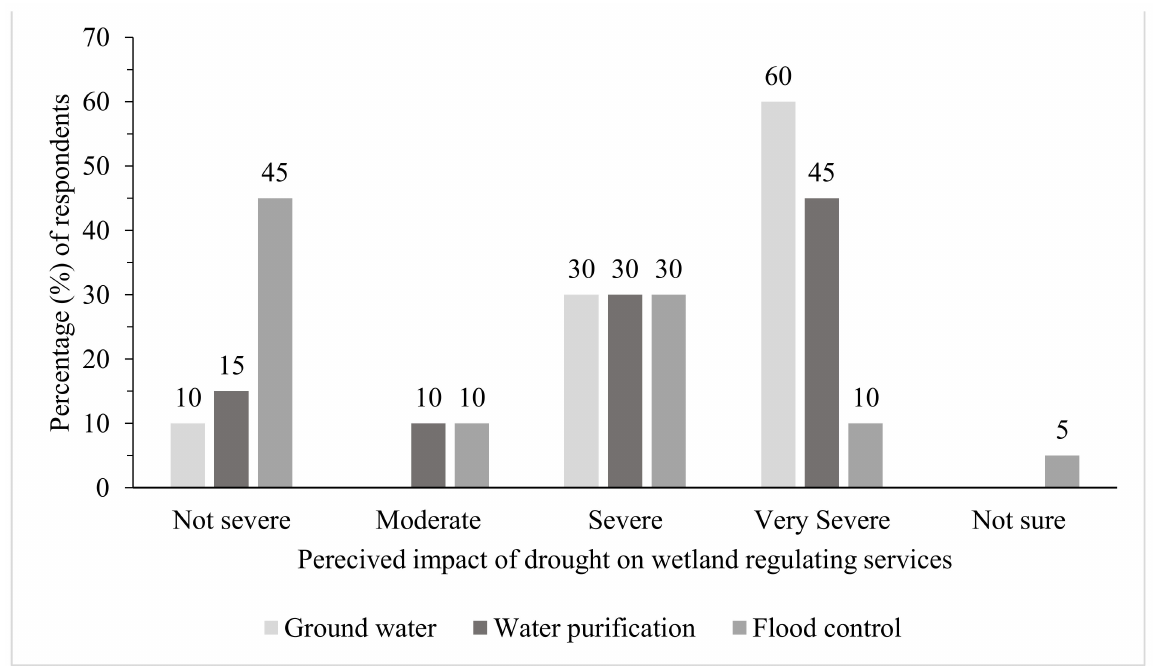
Figure 5. Perceived impact of drought on wetland regulating